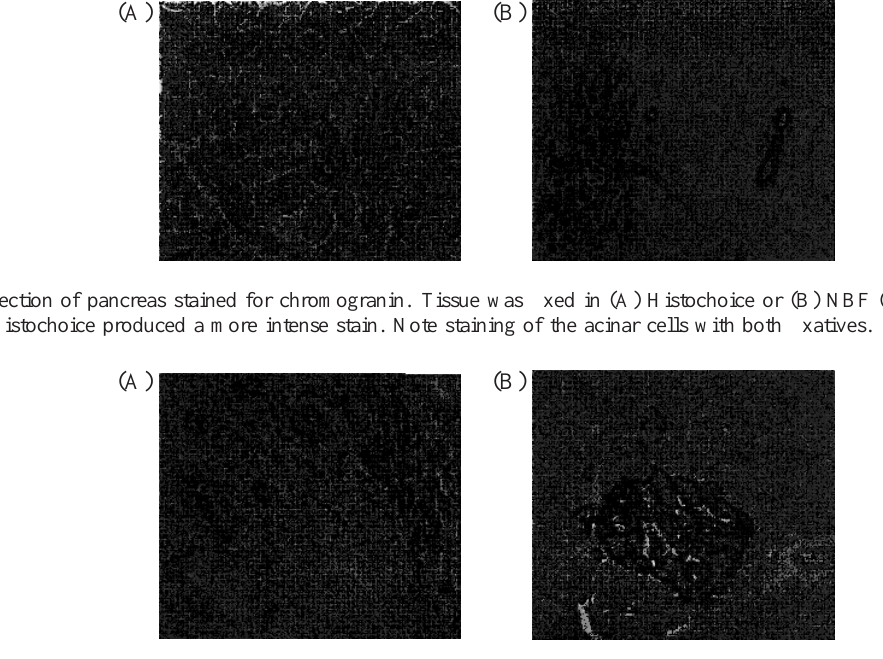
Fig. 2. Human tonsil stained for Factor VIII. Tissue was fixed in (A) Histochoice or (B) NBF (DAB chromogen, 200 × ). Histochoice produced a more intense stain.